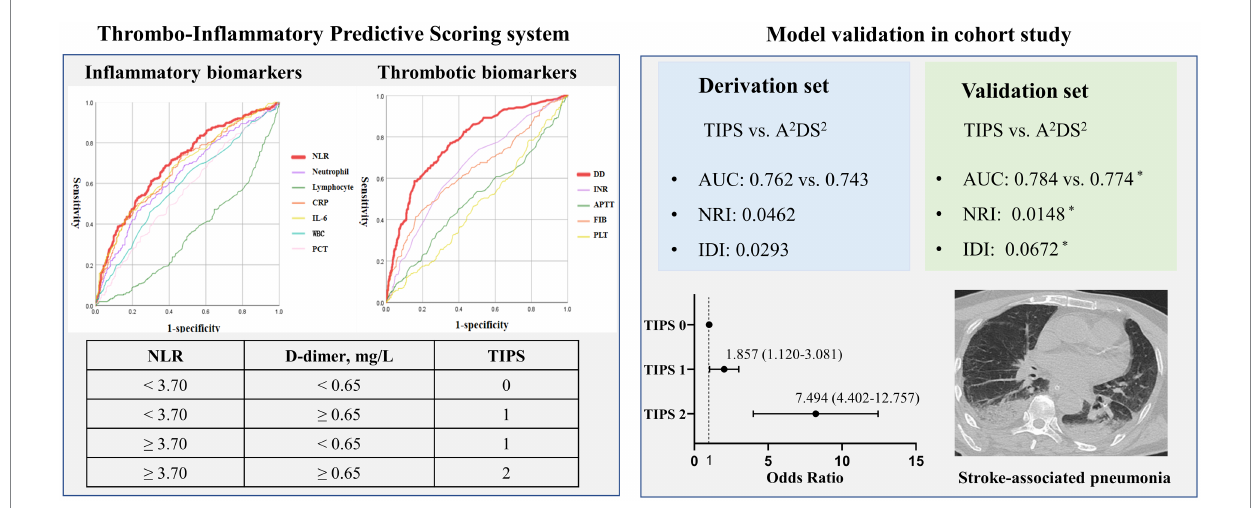
FIGURE 2 Visual summary: thrombo-inflammatory predictive scoring system (TIPS): early recognizing the risk of stroke-associated